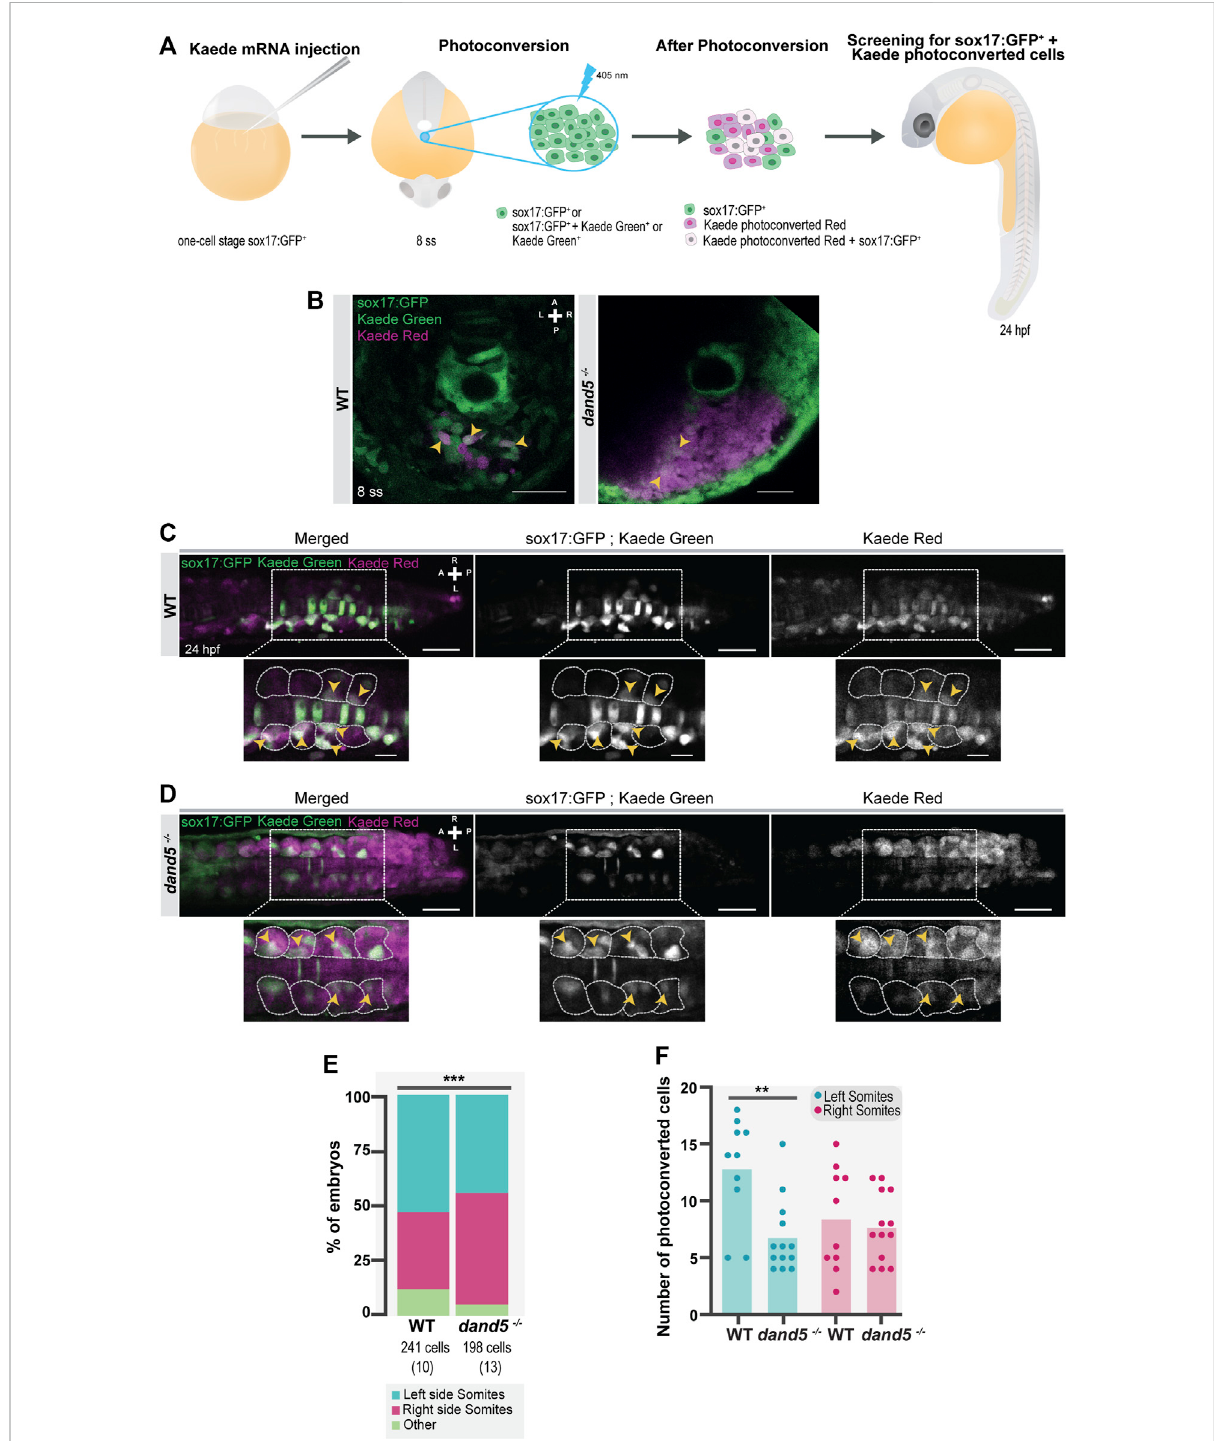
FIGURE 6 NKSTCsfatemapping. (A) Schematicrepresentationofthefatemapsetupusingthephotoconvertibleprotein,Kaede.One-cellstageTg(sox17: GFP) embryos were injected with Kaede mRNA. The “ posterior cluster ” was photoconverted at 8 ss embryos using UV light. After photoconversion, there were three populations of cells in the region of interest: sox17:GFP + (green), Kaede photoconverted (magenta), and Kaede photoconverted colocalized with sox17:GFP + (white). At 24 hpf, the embryos were screened for the location of Kaede photoconverted colocalized with sox17: GFP + cells.Thesameprocedurewasusedin dand5 − / − embryosin Tg ( sox17:GFP )background. (B) Kaedephotoconversionofthe “ posteriorcluster ” at